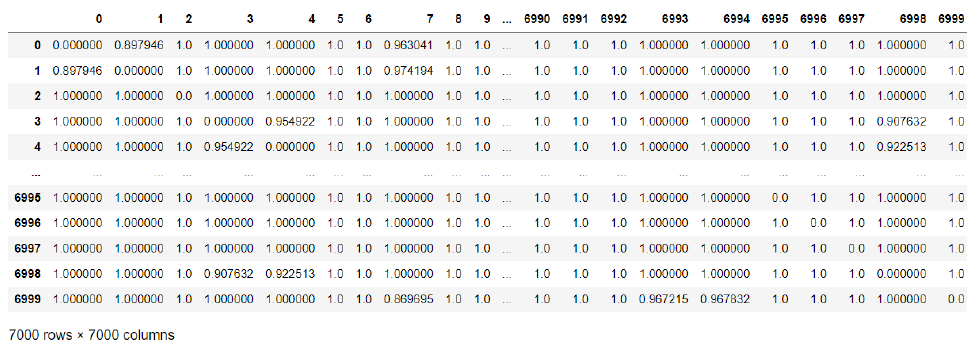
Figure 2. Distance Matrix for TF-IDF